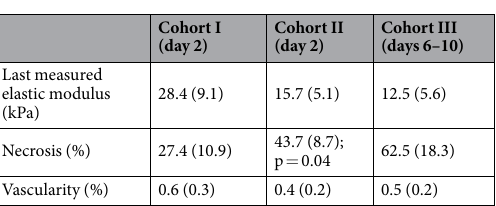
Table 2. Pathological results of all three cohorts. The data show the mean value for each group and each feature. Standard deviation values are given in